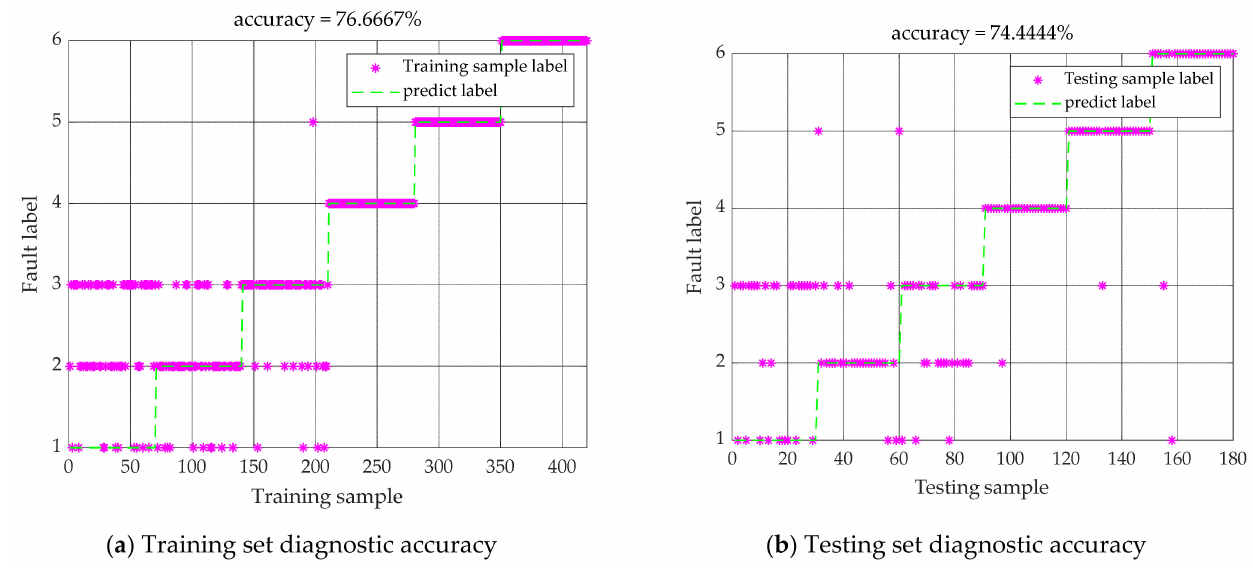
Figure 11. Classification results of